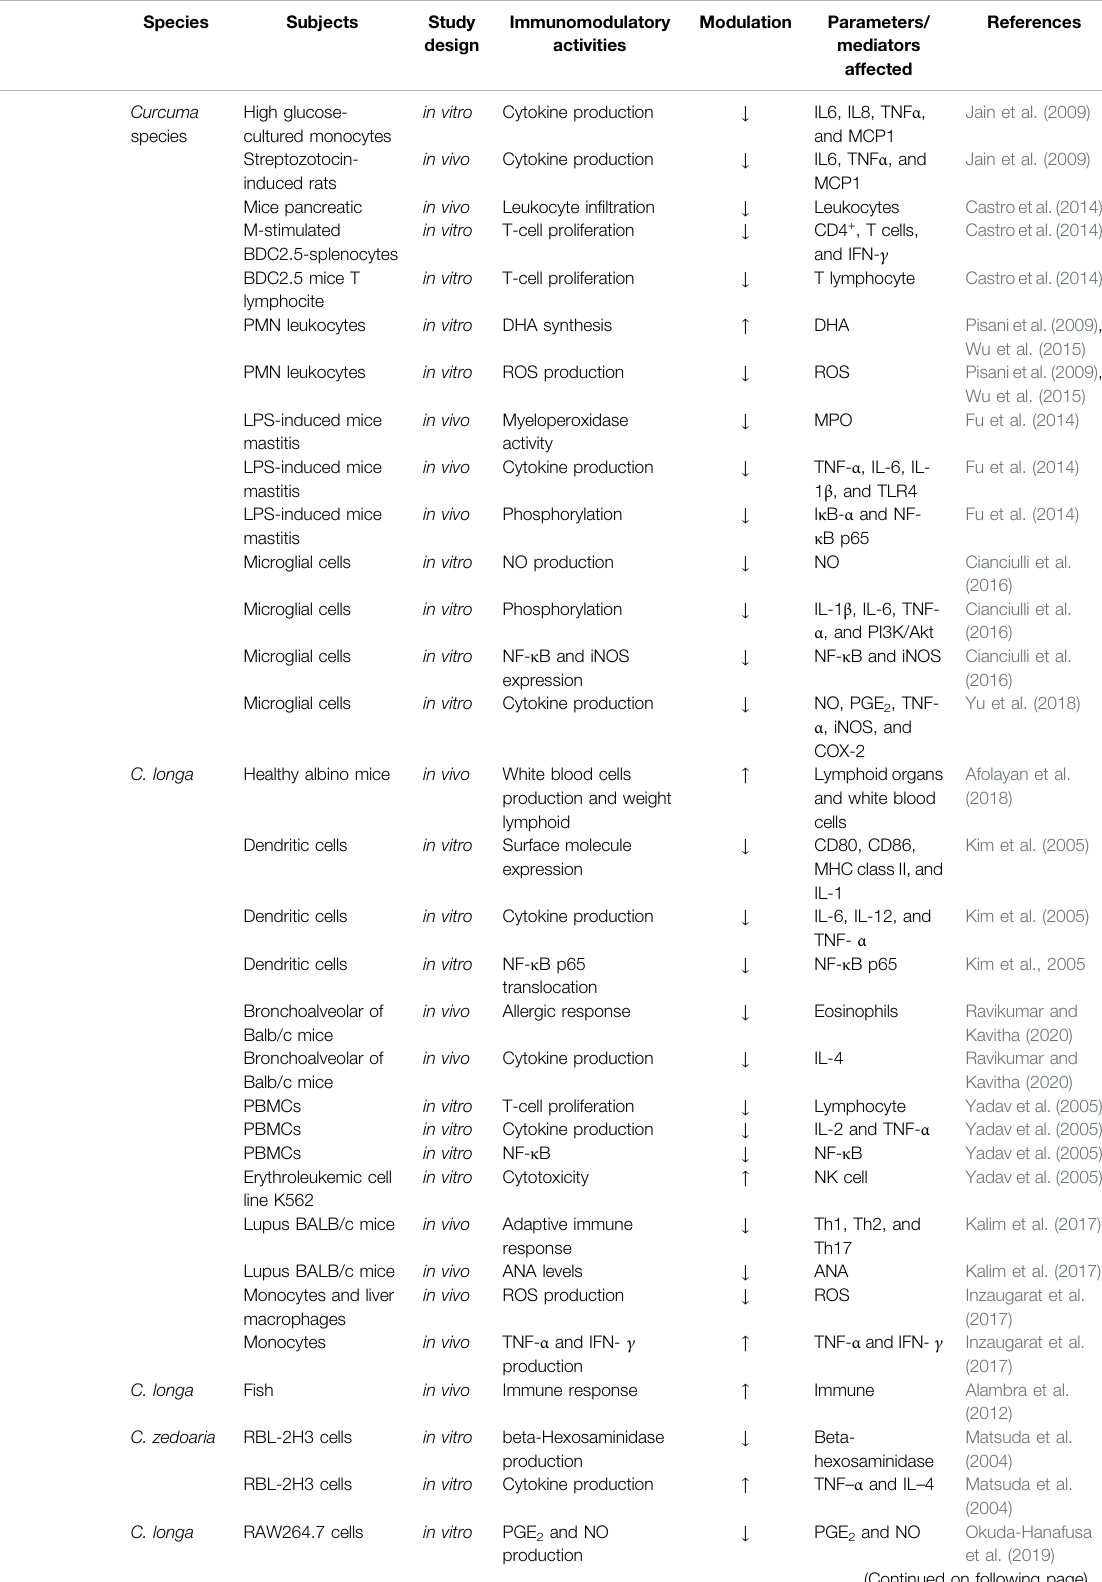
TABLE 2 | Bioactive compounds of Curcuma species with immunomodulating activity and their mechanisms of action. Main